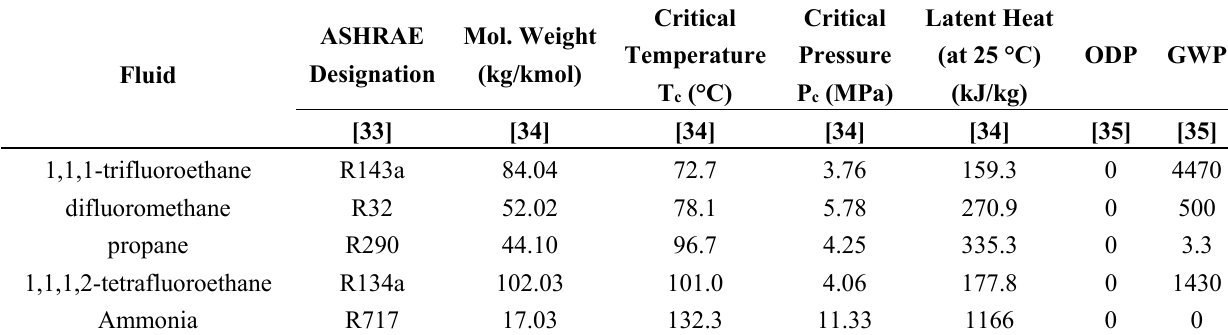
Table 3. Some properties of the working fluids considered in this